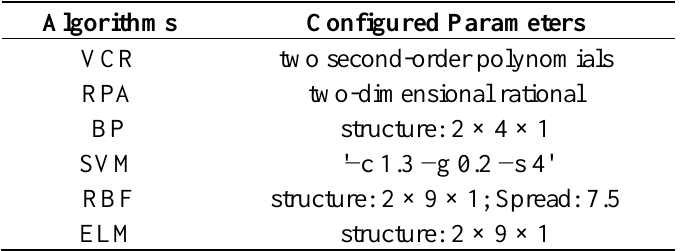
Table 3. Configured parameters of algorithms using 3 × 3